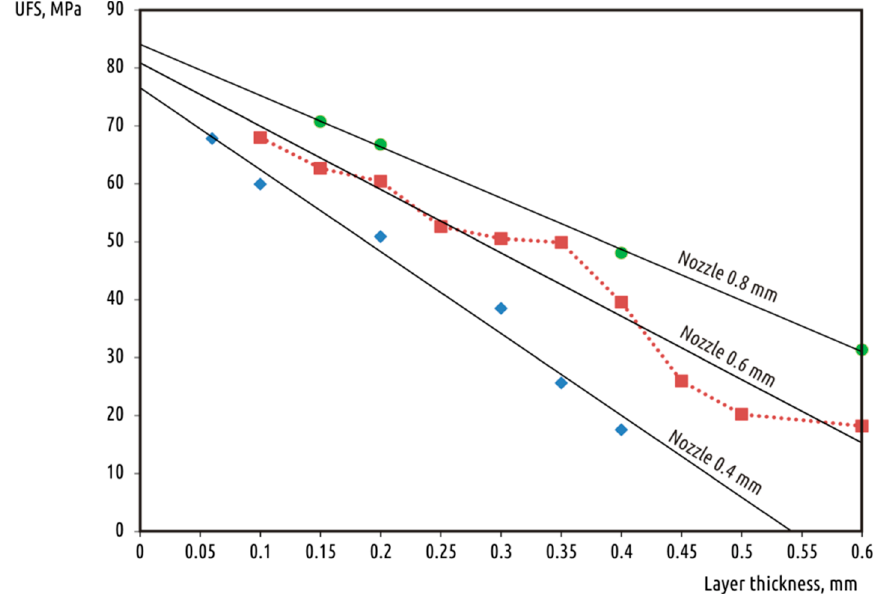
Figure 2. Ultimate flexural strength (UFS) of tested samples versus deposited layer height for all nozzles used.